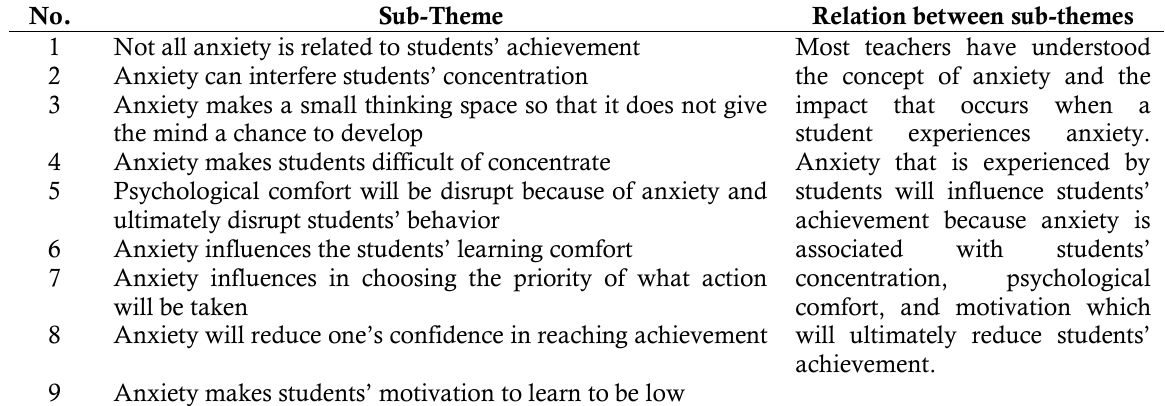
Table 1. The results of reduction regarding the relation of anxiety with aspects of achievement No. Sub-Theme Relation between